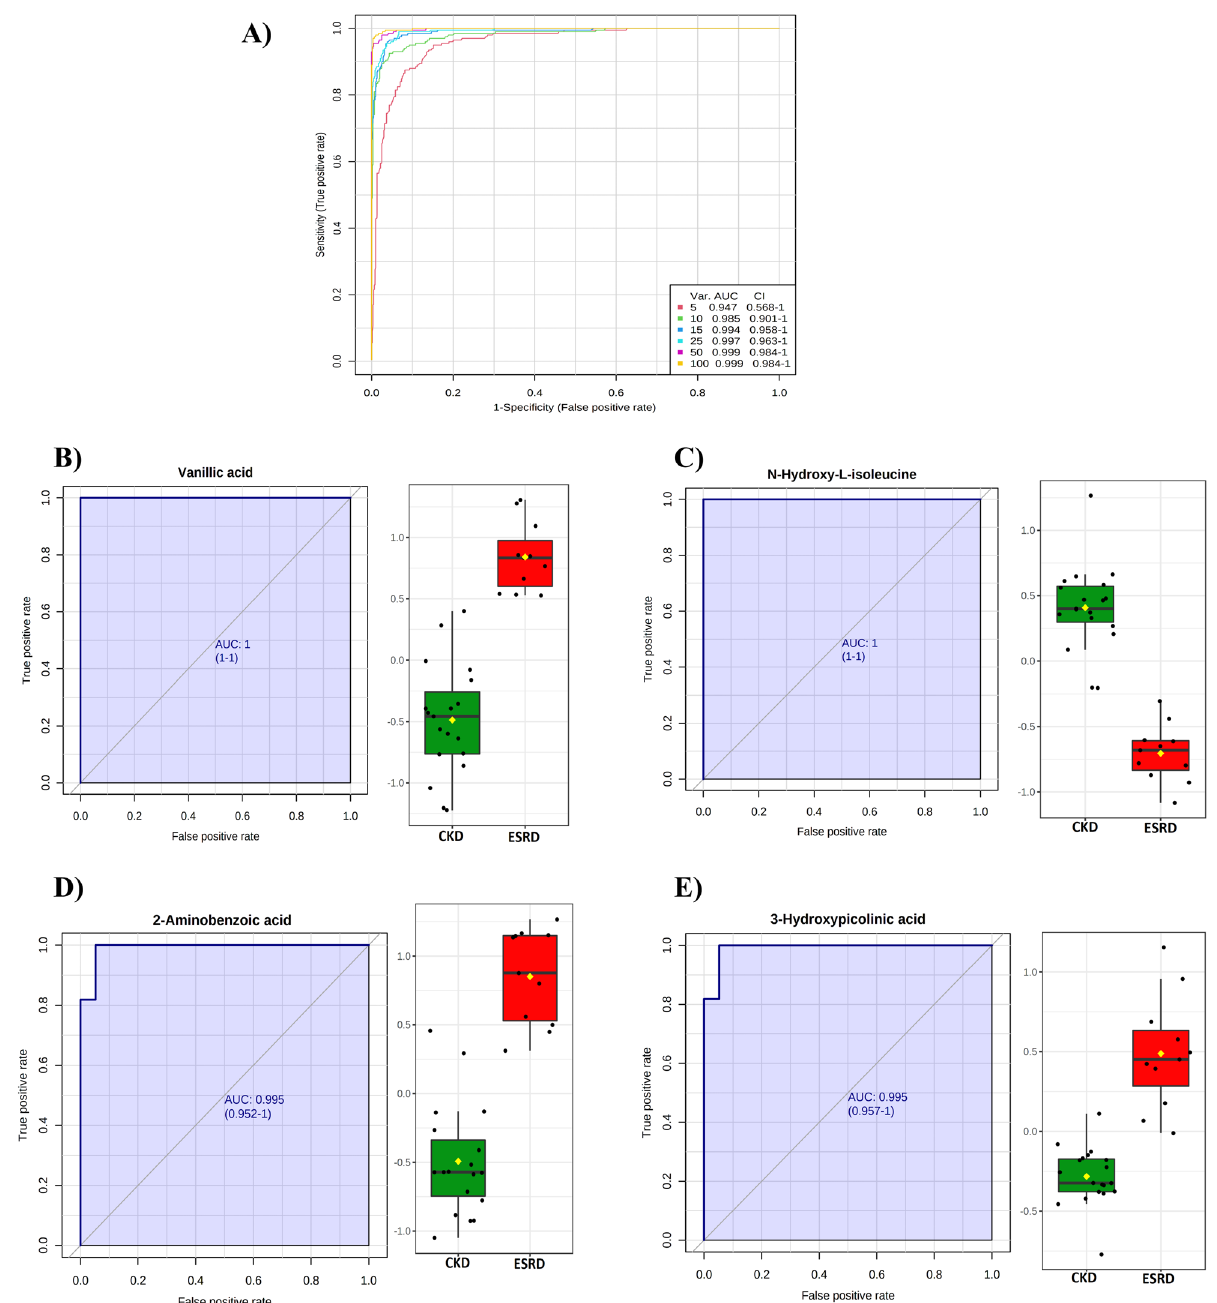
Figure 5. Receiver operating characteristics (ROC) curve for significantly altered metabolites between CKD and ESRD ( A ) The PLS-DA model produced a ROC with an area under the curve (AUC) of 0.985 for the top 10 variables. ( B ) Vanillic acid and ( C ) N -hydroxy isoleucine (both had AUC: 1) were up- and down-regulated in ESRD compared to CKD, respectively. ( D ) 2-aminobenzoic acid (AUC: 0.995) and ( E ) 3-hydroxypicolinic acid (AUC: 0.995) were up-regulated in ESRD compared to